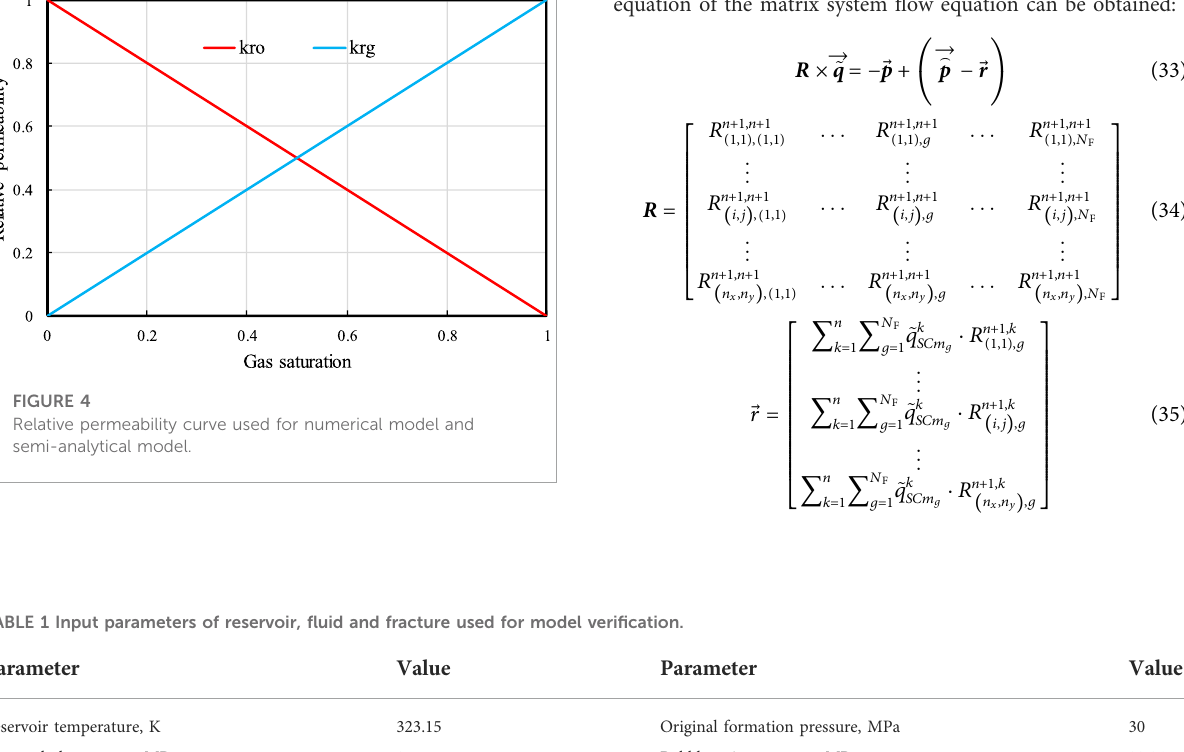
Reservoir temperature, K 323.15